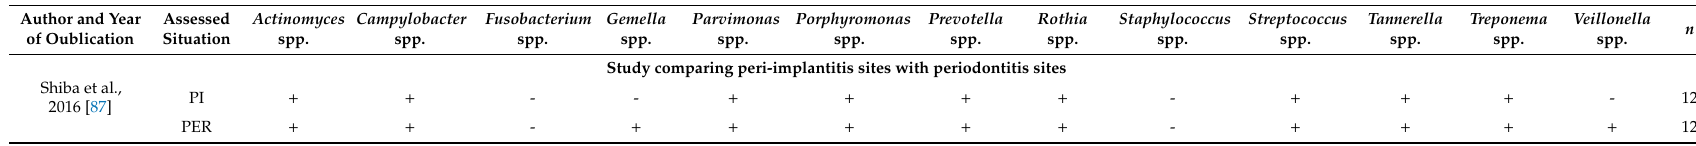
Table 6. Studies assessing di ff erent species using metatranscriptomic